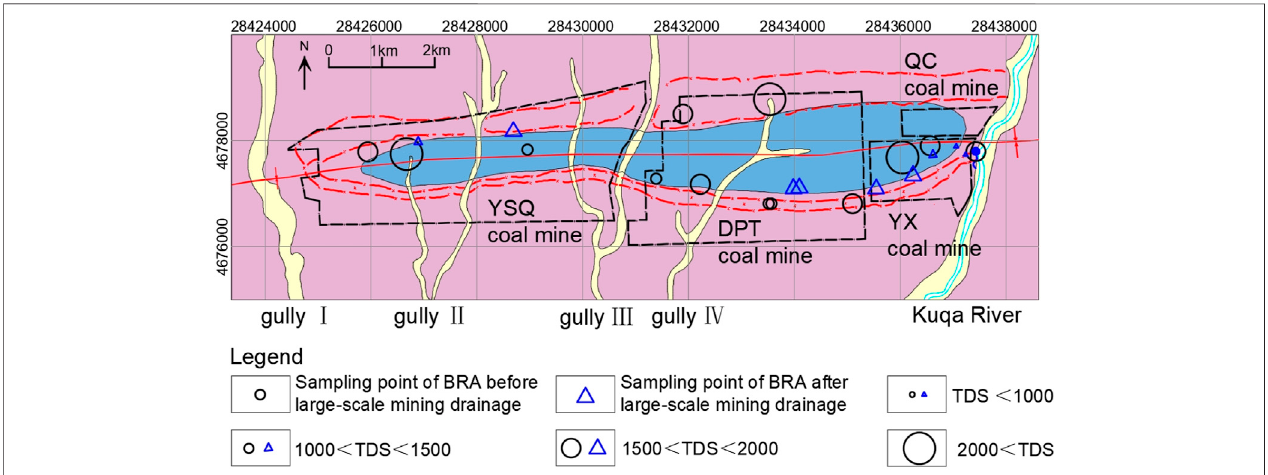
FIGURE 13 | Planar graph of the relationship between sampling location, time, and TDS in the BRA.